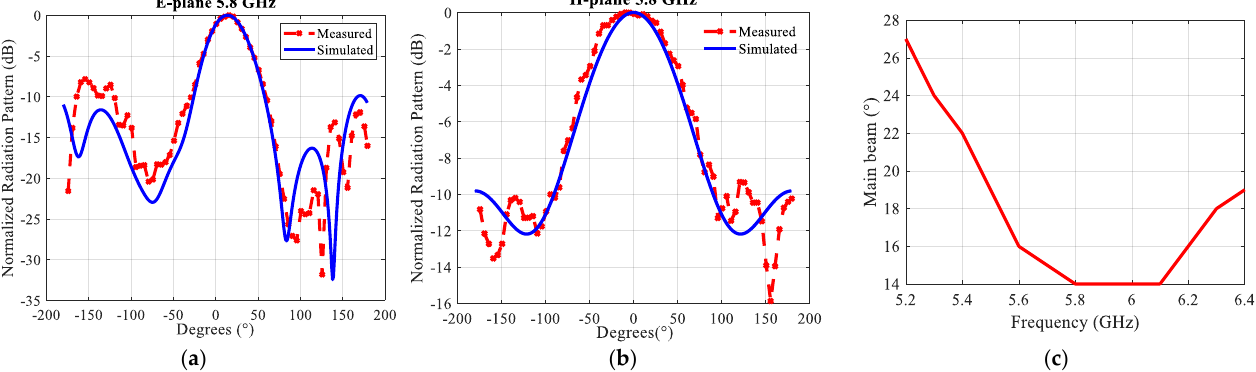
Figure 11. Simulated and measured normalized radiation patterns of the 2 × 1 building block with an air layer at 5.8 GHz: ( a ) In the E-plane; ( b ) In the H-plane; ( c ) Simulated direction of the main beam in the E-plane.